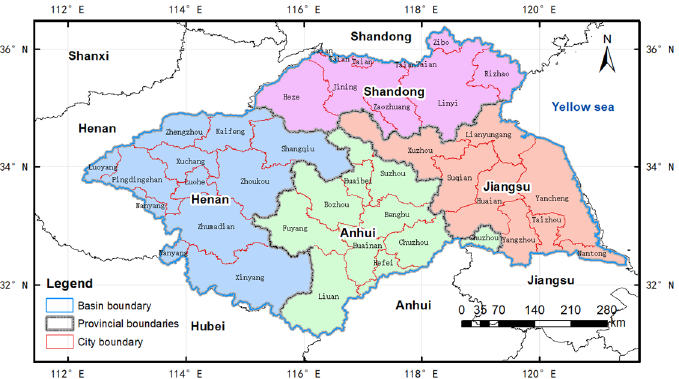
Figure 1. The Huaihe River Basin.